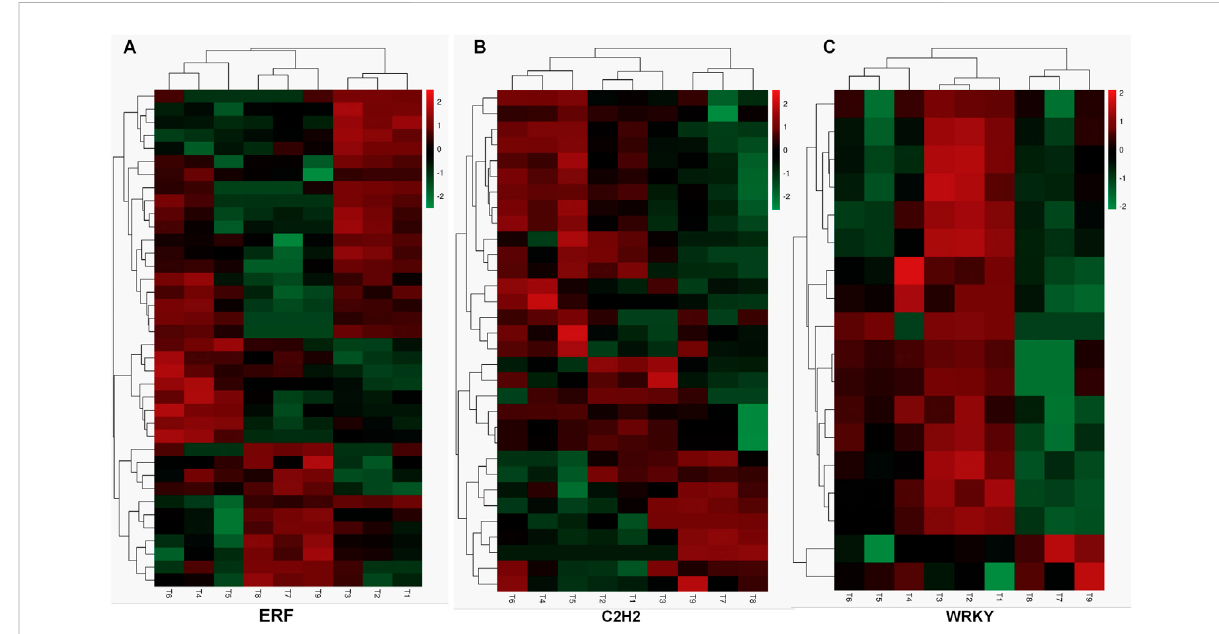
FIGURE 4 Heat-mapshowingrelativeexpressionlevelsofERF (A) ,C2H2 (B) ,andWRKY (C) .Redrepresentshighexpressionandgreencorrespondstolow